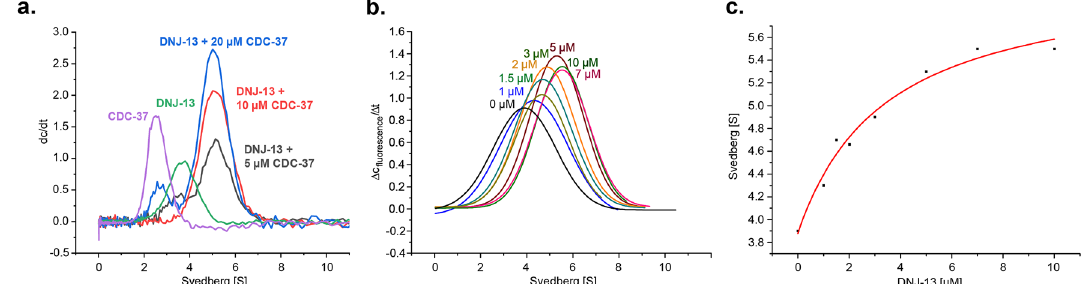
Figure 2. KD and stoichiometry determination. (a) Absorbance sedimentation velocity analysis of CDC-37 titration to 10 µM DNJ-13 in substoichiometric, equal and excess concentrations, as indicated. CDC-37 (purple) and DNJ-13 (green) serve both as control, as well as assistance for the indication of unbound protein used in the titration. ( b) Titration of varying DNJ-13 concentrations in AUC experiments to 100 nM *CDC-37, as indicated. ( c) Kinetics of CDC-37/DNJ-13 binding based on titrated DNJ-13 concentrations and measured sedimentation coefficient. Graphs were generated in OriginPro (Version